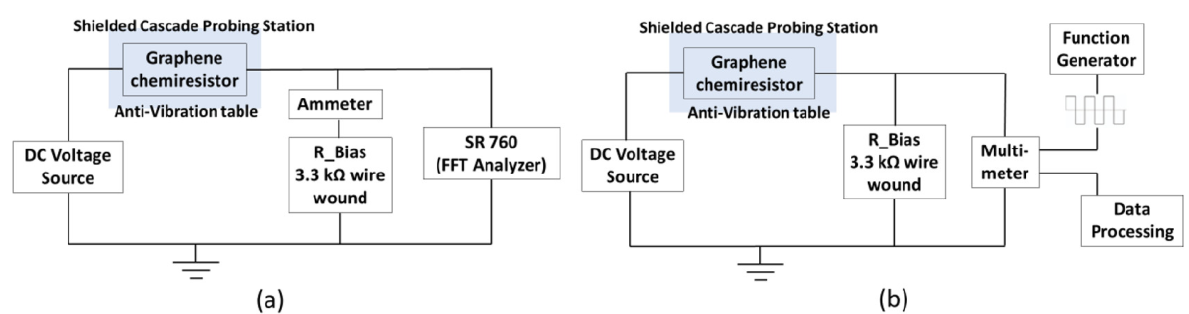
Figure 2. SR760 fast Fourier transform (FFT) spectrum analyzer noise measurement setup for graphene devices in a frequency range ( a ) from 0.24 Hz to 97.5 Hz and ( b ) from 0.001 Hz to 1 Hz at room temperature. A 3.3 k Ω wire wound resistor converted the induced current into a voltage for sampling either automatically by the SR760 or by an Agilent 34401A multimeter as triggered by an Agilent 33250A function